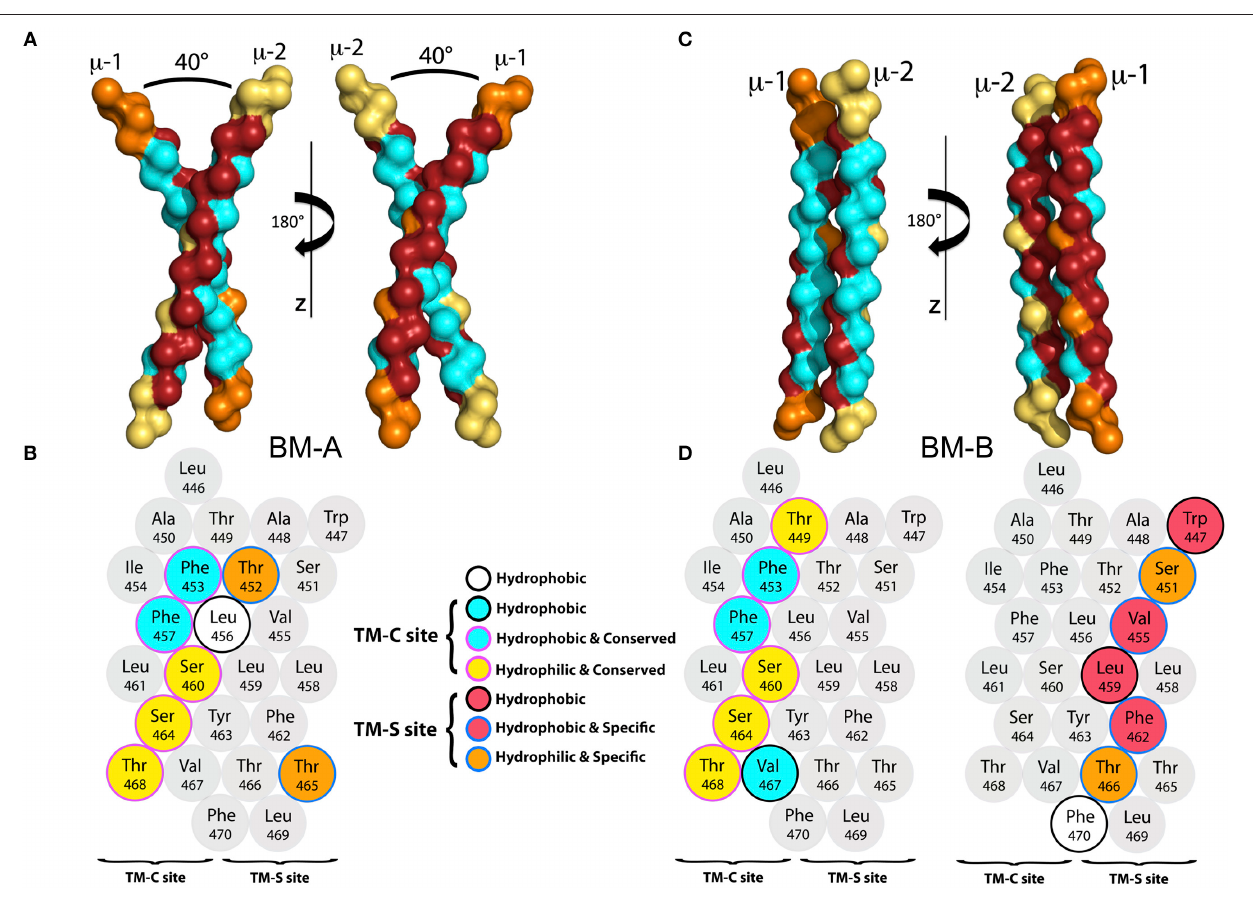
FIGURE 3 | (A) The backbone of the representative structure of the mIgM dimer conformer BM-A in surface-representation from two different perspectives. The conserved (TM-C) sites are colored in cyan, while the specific (TM-S) sites are colored in dark red. For clarity, amino acids that neither belong to the TM-C nor to the TM-S sites are colored orange for µ -1 and yellow for µ -2. (B) α -helical scheme of the µ heavy chain TMD. Residues that play a key role for BM-A formation are highlighted. (C) Backbone structure of a representative structure of the BM-B conformer in surface-representation from two different perspectives. The TM-C sites are colored in cyan, while the TM-S sites are colored in dark red. For clarity, amino acids that belong to neither the TM-C nor to the TM-S sites are colored orange ( µ -1) and yellow ( µ -2). (D) α -helical schemes of the µ heavy chain TMDs. Residues that play a key role for BM-B formation are highlighted for µ -1 and µ -2.